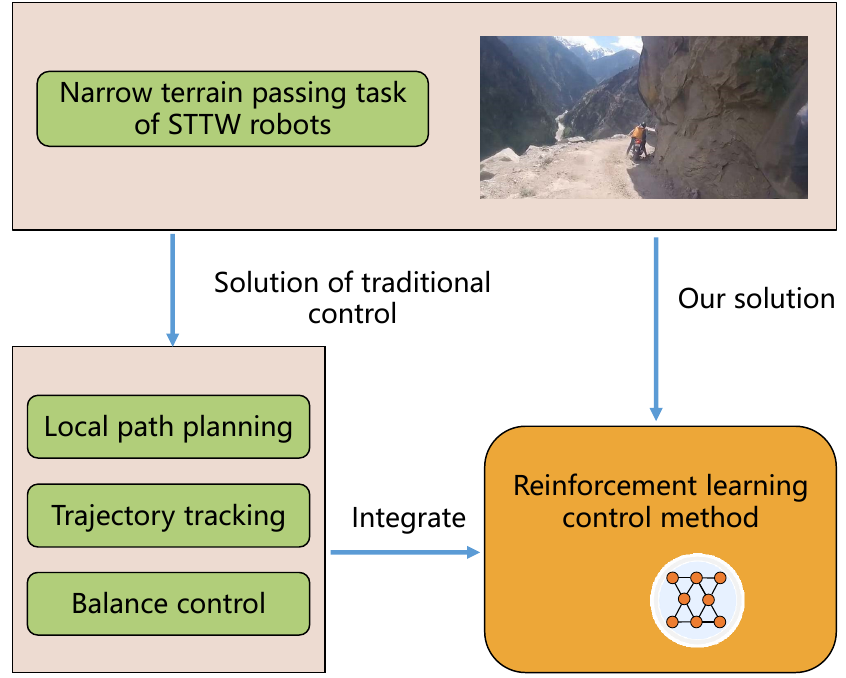
Figure 1. Solution for the narrow terrain passing task of the STTW robots. The primary contributions of this article are as follows: